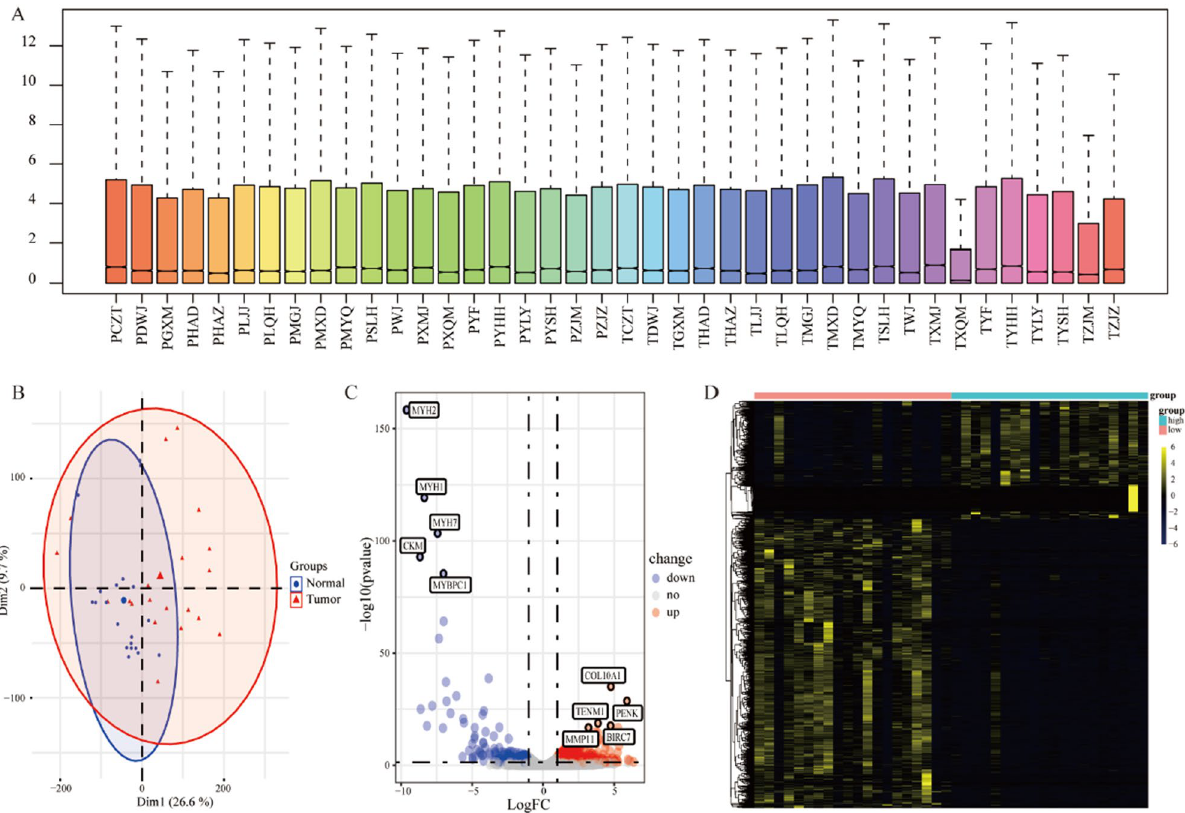
Figure 1. Differential gene expression analysis based on RNA sequencing (RNA-Seq) data of specimens collected from patients with THCA. ( A ) Boxplots show the comprehensive range of FPKM values for different genes in each tissue. ( B ) Principal component analysis (PCA) plots show the differences in gene expression in cancer and cancer-adjacent tissue samples. ( C ) Volcano plots and ( D ) heatmaps showing the respective expression levels of differentially expressed genes (DEGs) between cancer and cancer-adjacent tissues of patients with